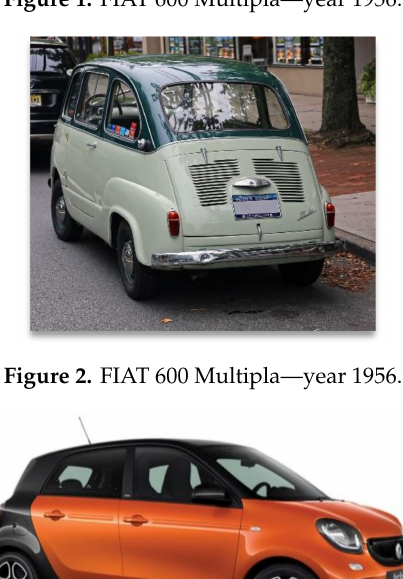
Figure 1. FIAT 600 Multipla—year 1956.